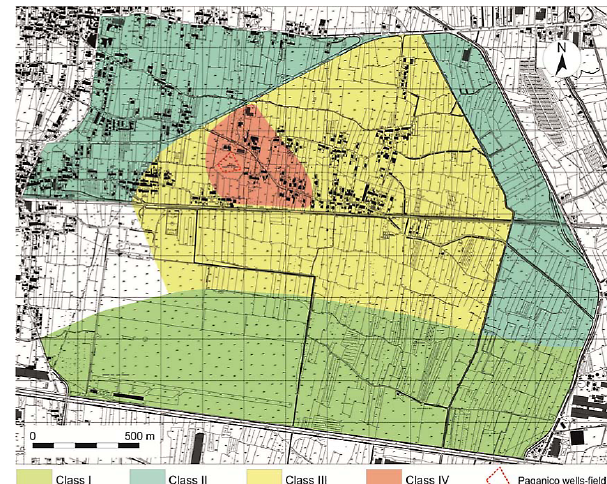
Fig. 14. Hydraulic gradient ( i ) map; class I ( i = 0): lack of sinkhole- like features and vertical conduits; class II (0 . 1 < i < 0 . 6): sporadic phenomena; class III (0 . 6 < i < 1): 70% of identified phenomena (sinkhole-like features: diameter and depth < 1m; vertical conduits: diameter < 4cm); class IV (1 < i < 1 . 9): 20% of identified phe- nomena (sinkhole-like features: diameter 0.7-2,8 m, depth 0.6–2m; vertical conduits diameter: